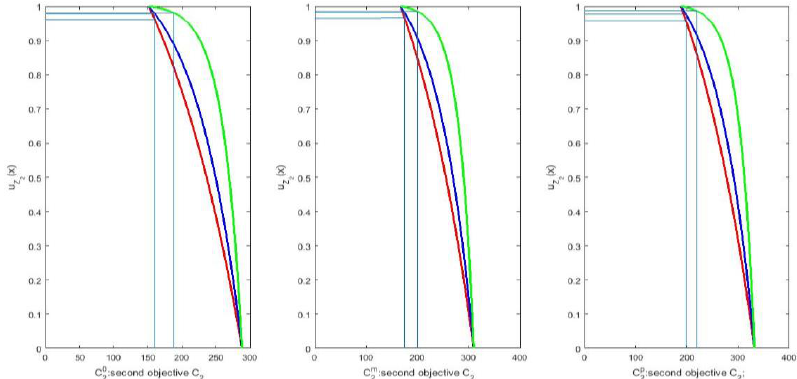
Figure 4. The degree of satisfaction of the second objective for α=0.1